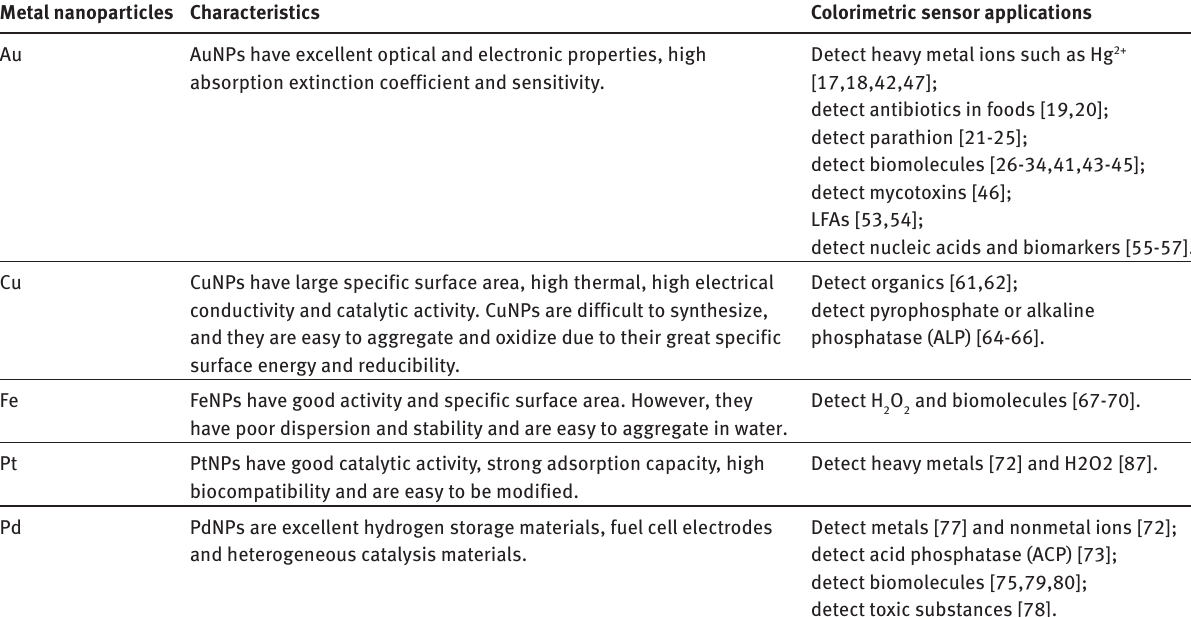
Table 1: Comparison of the properties of different metal NPs and the application of colorimetric sensors Metal nanoparticles